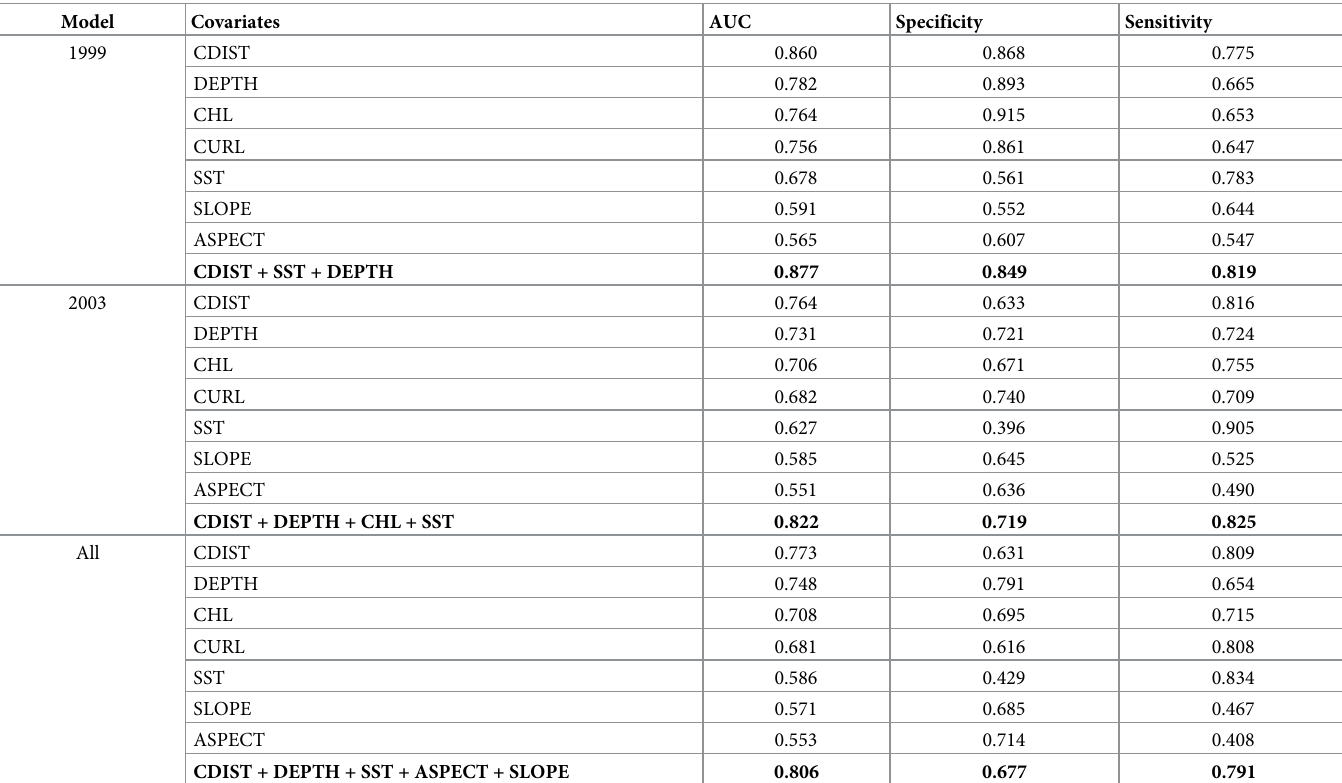
Covariate abbreviations as follows: Distance from colony (CDIST); chlorophyll concentration (CHL) and sea surface temperature (SST). Bold face indicates the covariates and their AUC, specificity and sensitivity values for the best fitting model for each period. Further details of each stage of cross-validation, and individual variable contributions are available in the S1-S3 Tables in S1